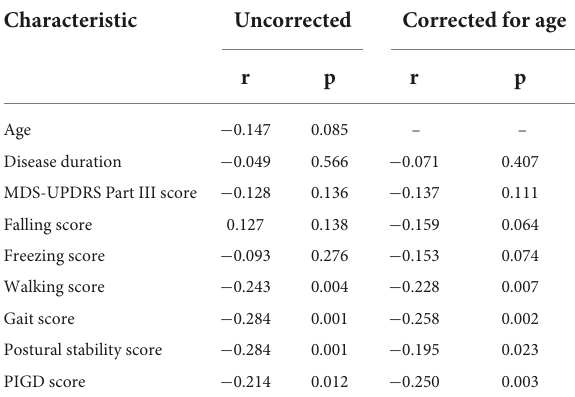
frontal gyrus and any other voxel in the brain (p < 0.001 at the voxel level and a false discovery rate-adjusted p < 0.05 at the cluster